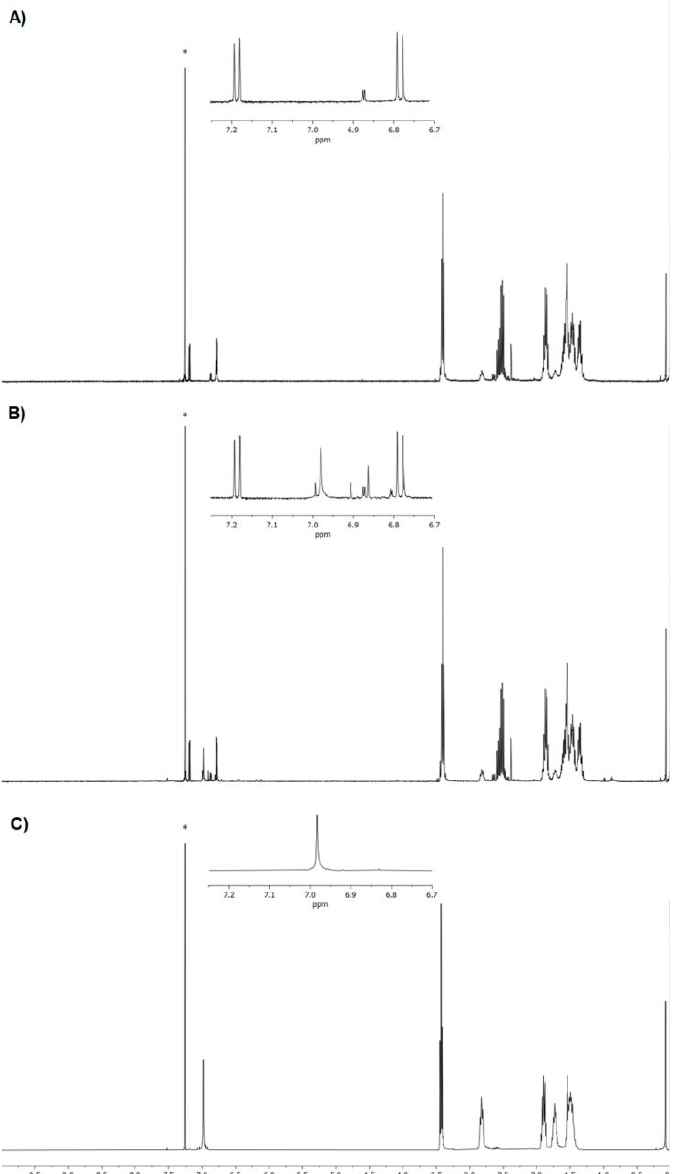
Figure 1. 1 H-NMR spectra of PT6Br after 30 min ( A ), 60 min ( B ) and 90 min ( C ). Asterisk: solvent resonance (CDCl 3 ). Inset: expansion of the aromatic region.